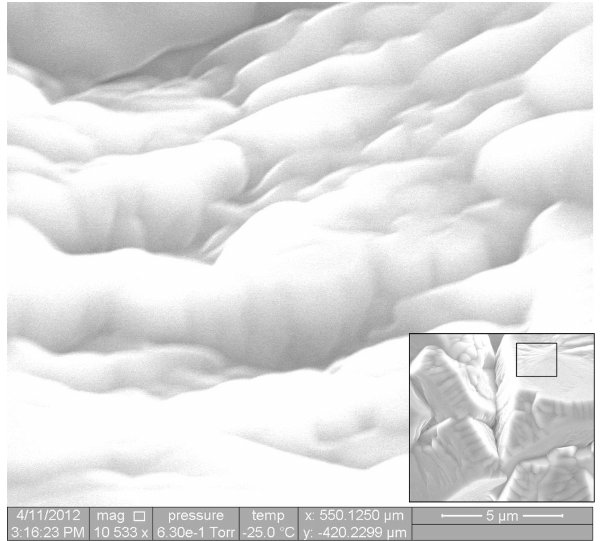
Figure 6. Ice crystals are observed at high magnification, the high- est we were able to attain without sacrificing the quality of the im- age. The inset image (1903 × magnification) shows the location of the high-magnification zoom, located on the basal facet of a grow- ing crystal, and near to the intersection of the adjoining prism facet with another crystal’s basal facet. Data detail available in